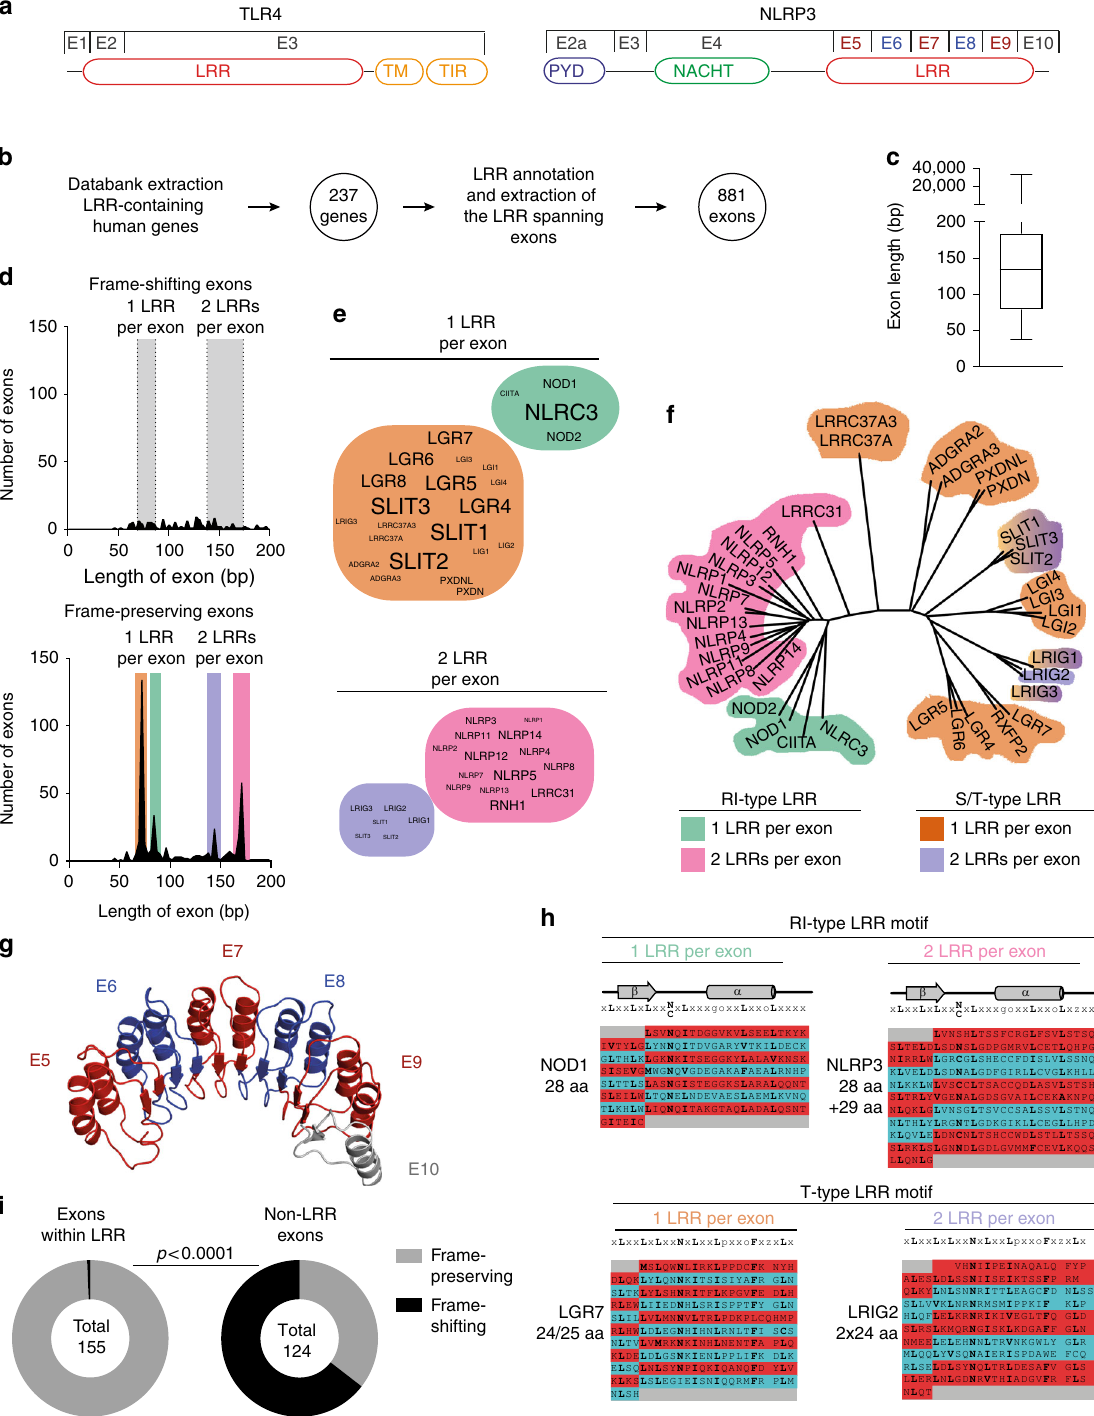
Fig. 1 LRR domains of the NLR family have a conserved multi-exon organization. a Scheme of domain and exon distribution in TLR4 and NLRP3. b Work fl ow for the selection of LRR exons used in c – f . c Length distribution of exons extracted in b . Box indicates 25th to 75th percentile, the middle line indicates the median, whiskers indicate min and max values. d All exons up to 200 bp in length plotted for their frequency distribution. Exons were divided in frame- shifting or frame-preserving. The typical length of LRRs (23 to 29 aa) is indicated as gray boxes. Colored boxes in the lower panel match assignment of groups in the following sub fi gures. e Genes in word clouds represent those genes whose exons contribute to the respective peaks in d . Word size is linearly dependent to the number of contributing exons. f Phylogenetic analysis of all genes contributing to the 4 major peaks in d . g Model of the NLRP3 LRR based on the human ribonuclease inhibitor LRR crystal structure. h LRR consensus sequences and structural alignments for the four groups identi fi ed in d – f . i Quanti fi cation of all LLR exons vs. non-LRR exons of all NLRs which would be frame-shifting if alternatively spliced. Independence of distribution was calculated using two-tailed Fischer ’ s exact test. See also Supplementary Fig. 1. Source data are provided as a Source Data fi le